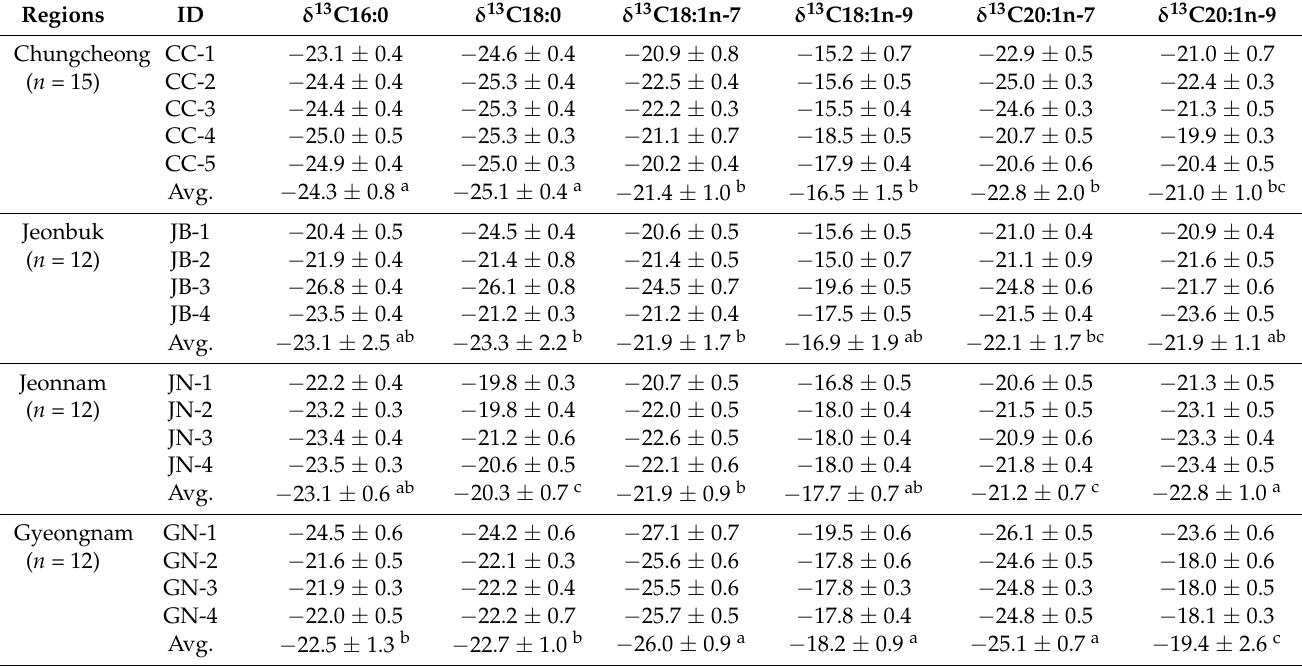
Table 4. Carbon isotopic values (‰) of FAs of the Manila clam Ruditapes philippinarum with different geographical origins. Each value was represented as the average isotope ratios ( ± SD) of three samples. Different letters indicate significant differences in δ 13 C-FAs with respect to regions (ANOVA, Tukey’s, p <